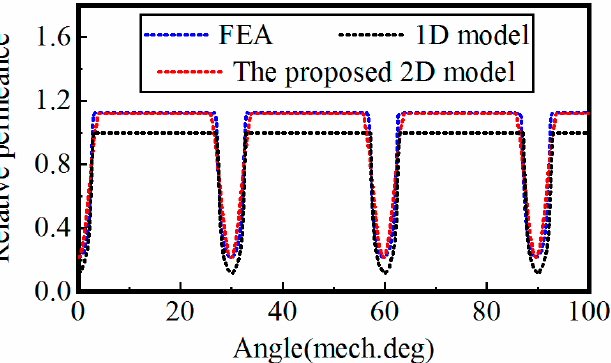
Figure 9. Permeance analytical results comparison with FEA results ( r = R i 1 − δ /2).